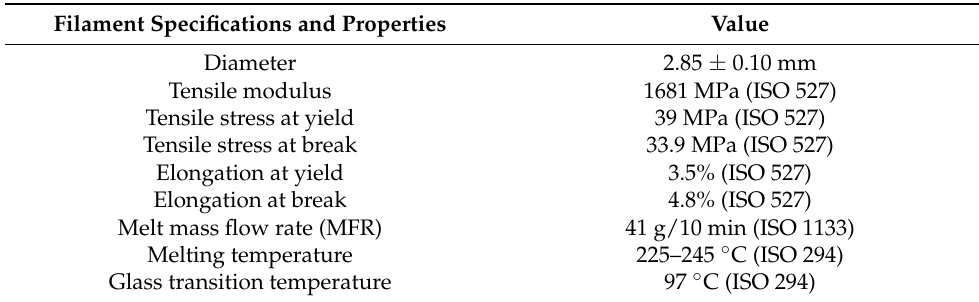
Table 2. Filament specifications, and mechanical and thermal properties of the Ultimaker® ABS (RAL 3020) [33].